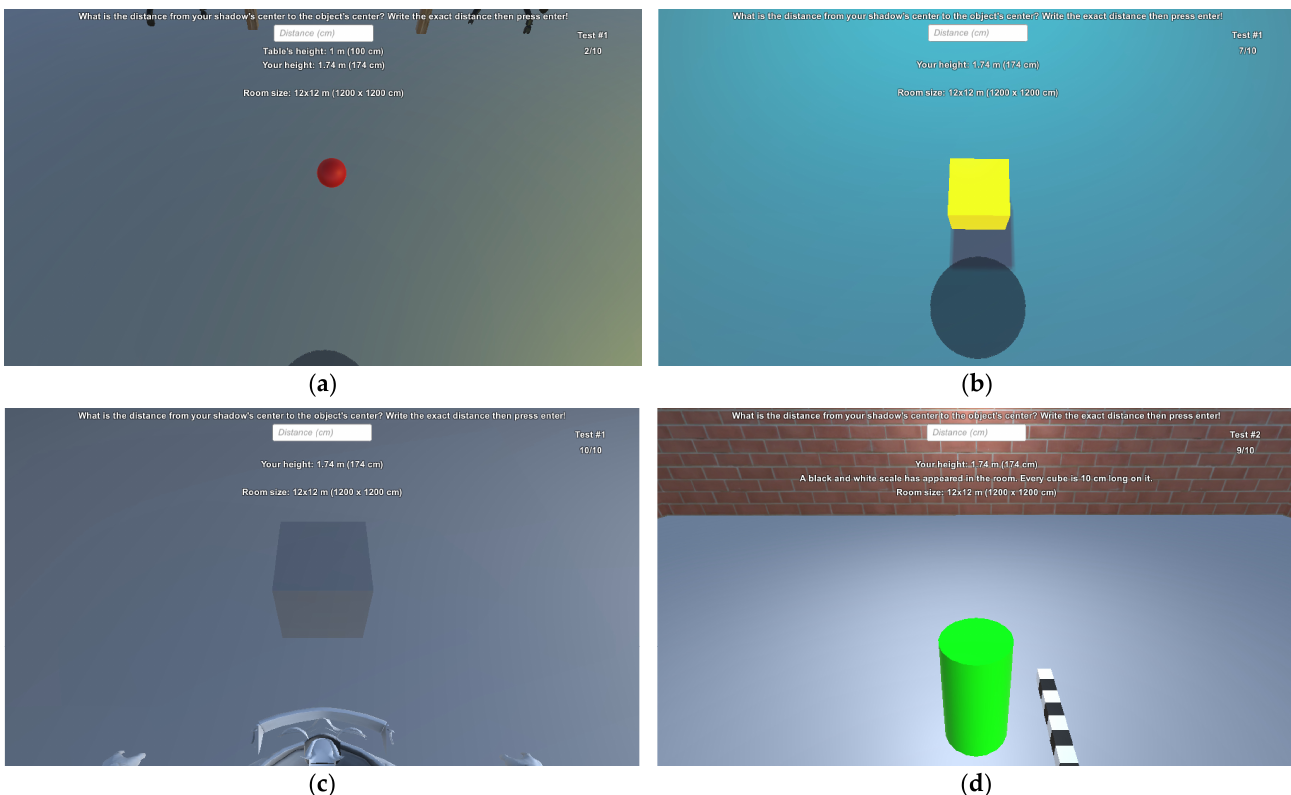
Figure 1. Different randomizations in the VE (not all factors are mentioned in the following description): ( a ) red sphere with a height of 20 cm, furniture, no body, yellow light at right, darker floor, no object shadows, no scale on the ground; ( b ) yellow cube with a height of 30 cm, no furniture, no body, cyan light in front, lighter floor, object shadows, no scale on the ground; ( c ) transparent cube with a height of 40 cm, no furniture, body, white light at right, darker floor, no object shadows, no scale on the ground; ( d ) green cylinder with a height of 50 cm, no furniture, white light in front, lighter floor, no object shadows, scale on the ground.